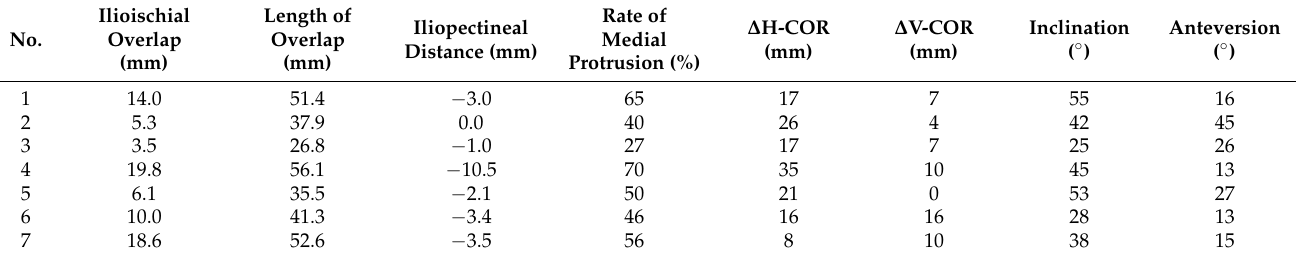
Table 2. Radiological measurements after the index operation.